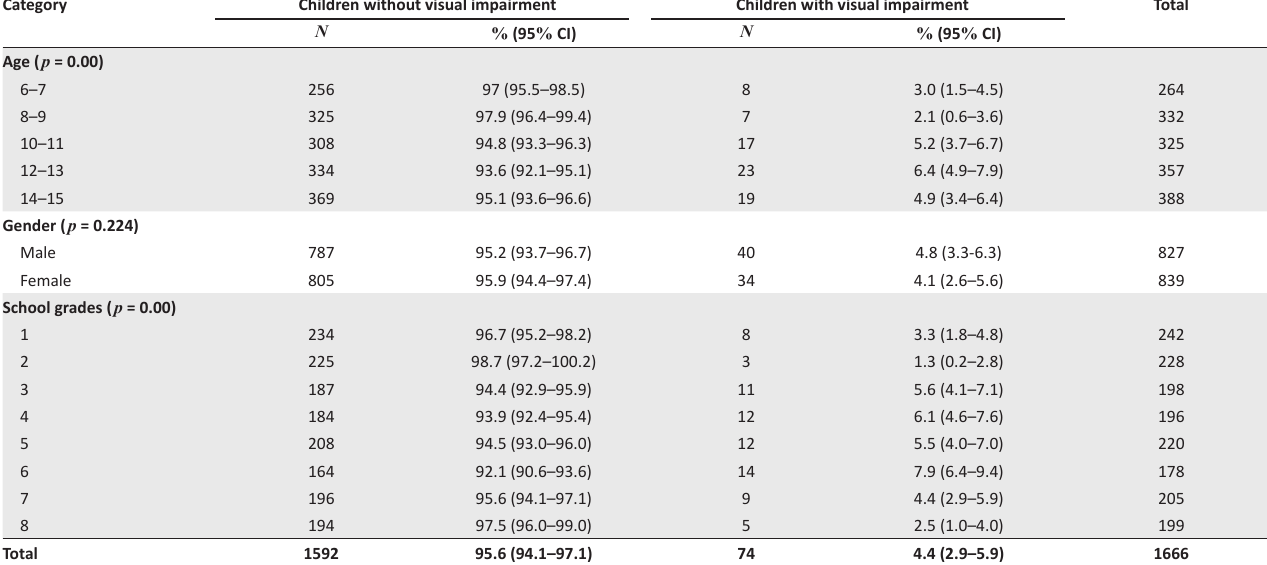
TABLE 2: Prevalence of visual impairment among school-aged children by age groups, gender and school grade. Category